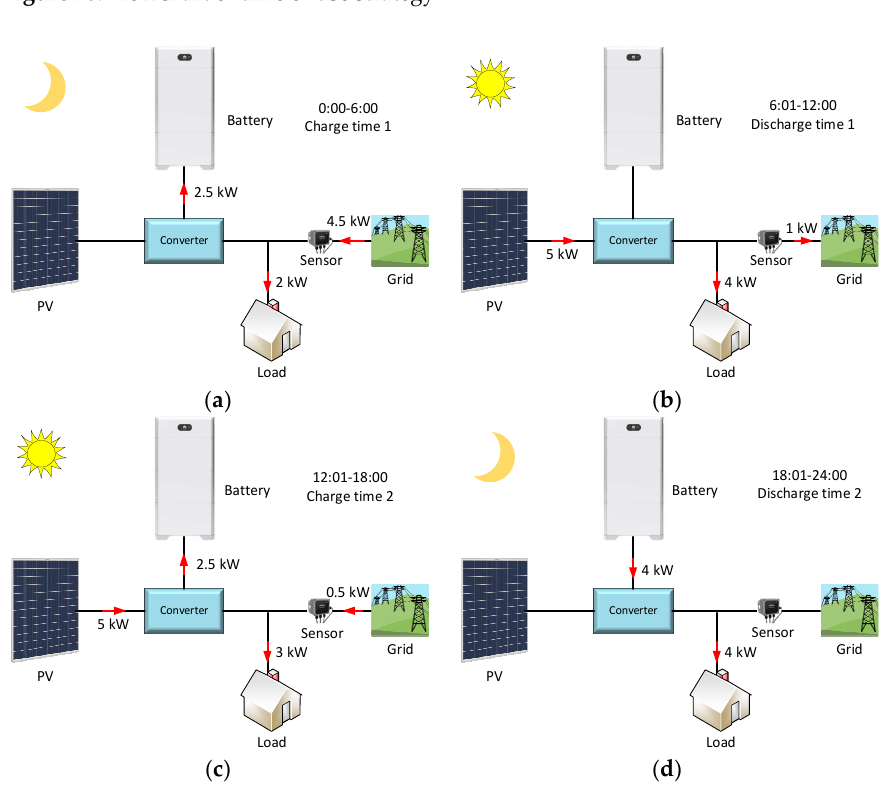
Figure 11. Examples of the time of use strategy.